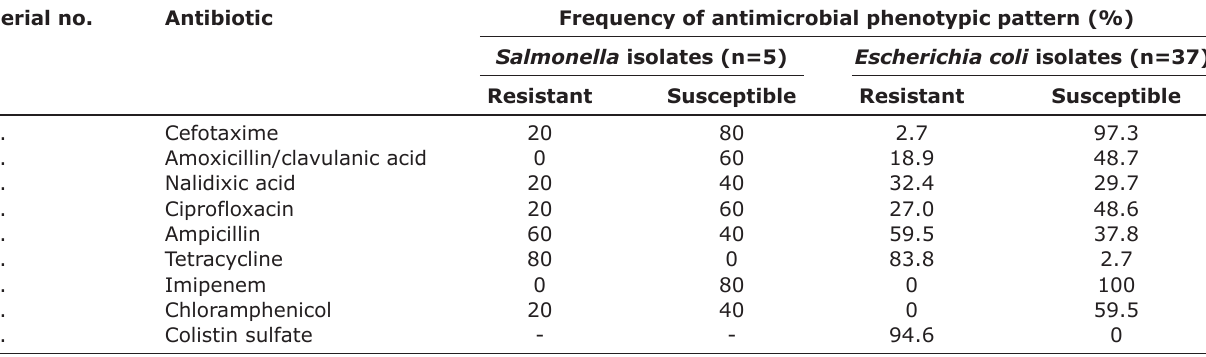
NB: Intermediate resistance profiles are not included in the table. KEY: (-)=Not